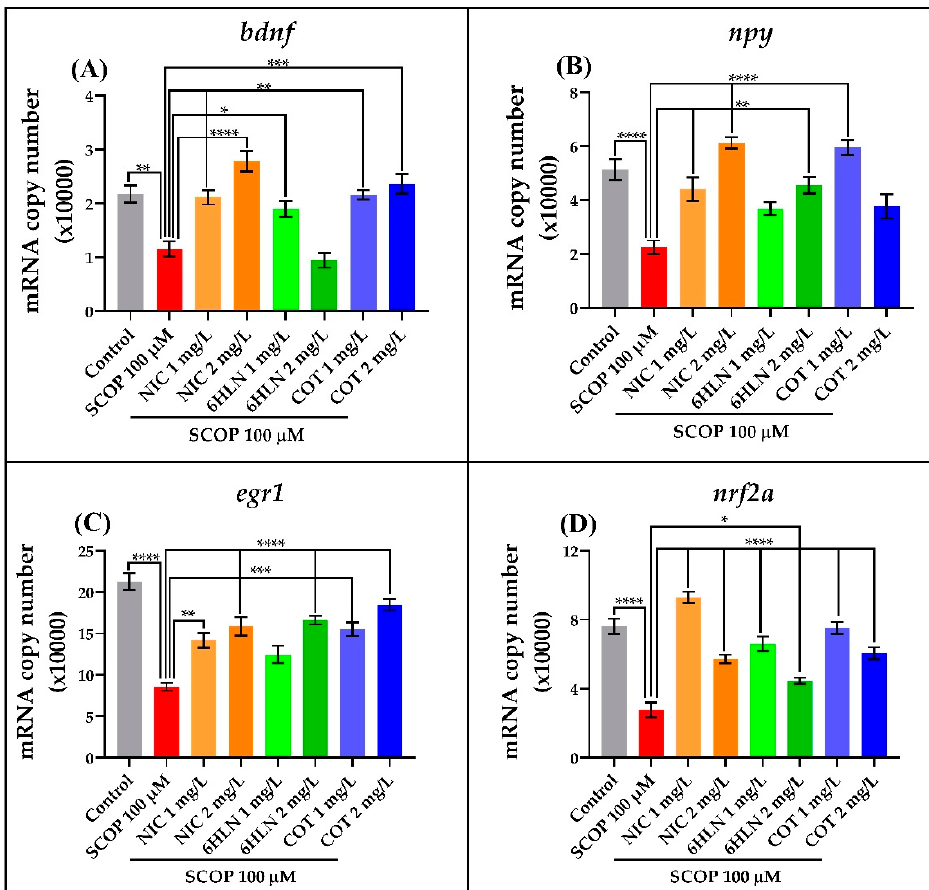
Figure 7. Effects of nicotine (NIC), cotinine (COT), and 6-hydroxy-L-nicotine (6HLN) (1 and 2 mg/L) administration on brain-derived neurotrophic factor ( bdnf ) ( A ), neuropeptide Y ( npy ) ( B ), early growth response protein 1 ( egr1 ) ( C ), and nuclear factor erythroid 2-related factor 2 ( nrf2a ) ( D ) gene expression. The values are expressed as means ± S.E.M. ( n = 4). ANOVA analysis identified overall significant differences between groups for ( A ) F(7,24) = 16.65, p < 0.0001, ( B ) F(7,24) = 14.79, p < 0.0001, ( C ) F(7,24) = 19.87, p < 0.0001 and ( D ) F(7,24) = 32.96, p < 0.0001. For Tukey posthoc analyses—**** p < 0.0001, *** p < 0.001, ** p < 0.01 and * p < 0.05.